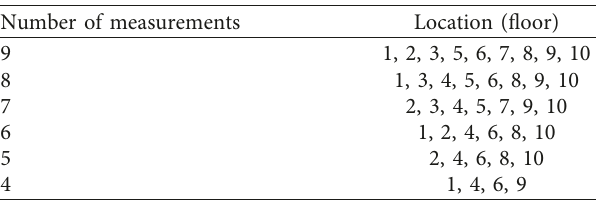
Table 6: Number of measurements and corresponding